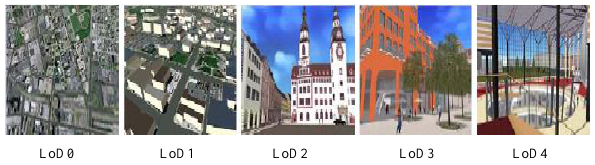
Fig. 2. Multi-scale concept in CityGML (Sester, 2007) Storing the same dataset in different scale ratio (pre-defined datasets) and databases will introduce data redundancy in term of geometry and attribute. Thus, it consumes a lot of storage volume as compared to store only a single dataset (most detailed) and undergoes any generalization process for a less detailed layer.